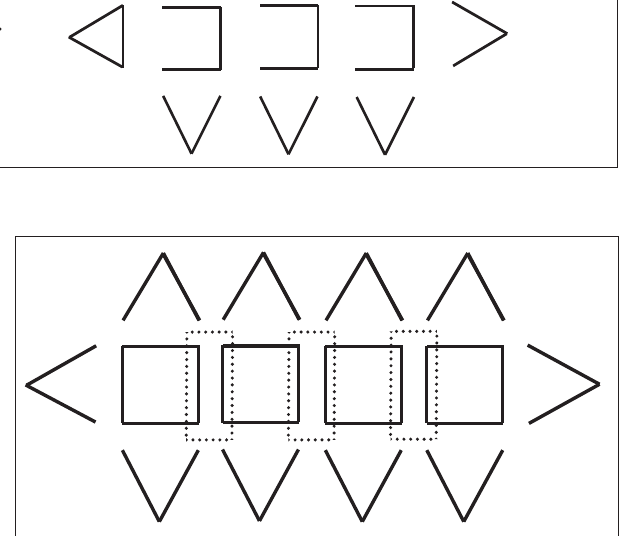
FIGURE 10: Terry’s final global visualisation of overlapping squares.